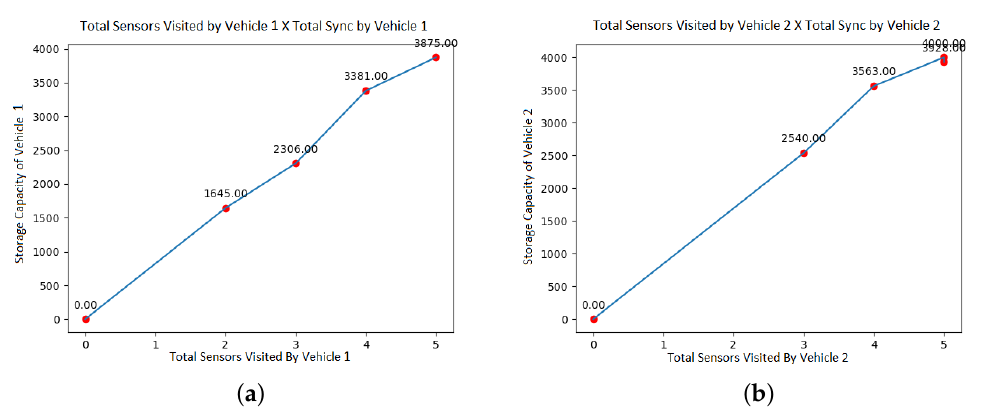
Figure 3. Total sensors visited versus total sync. ( a ) Total sensors visited by Vehicle 1. ( b ) Total sensors visited by Vehicle 2.